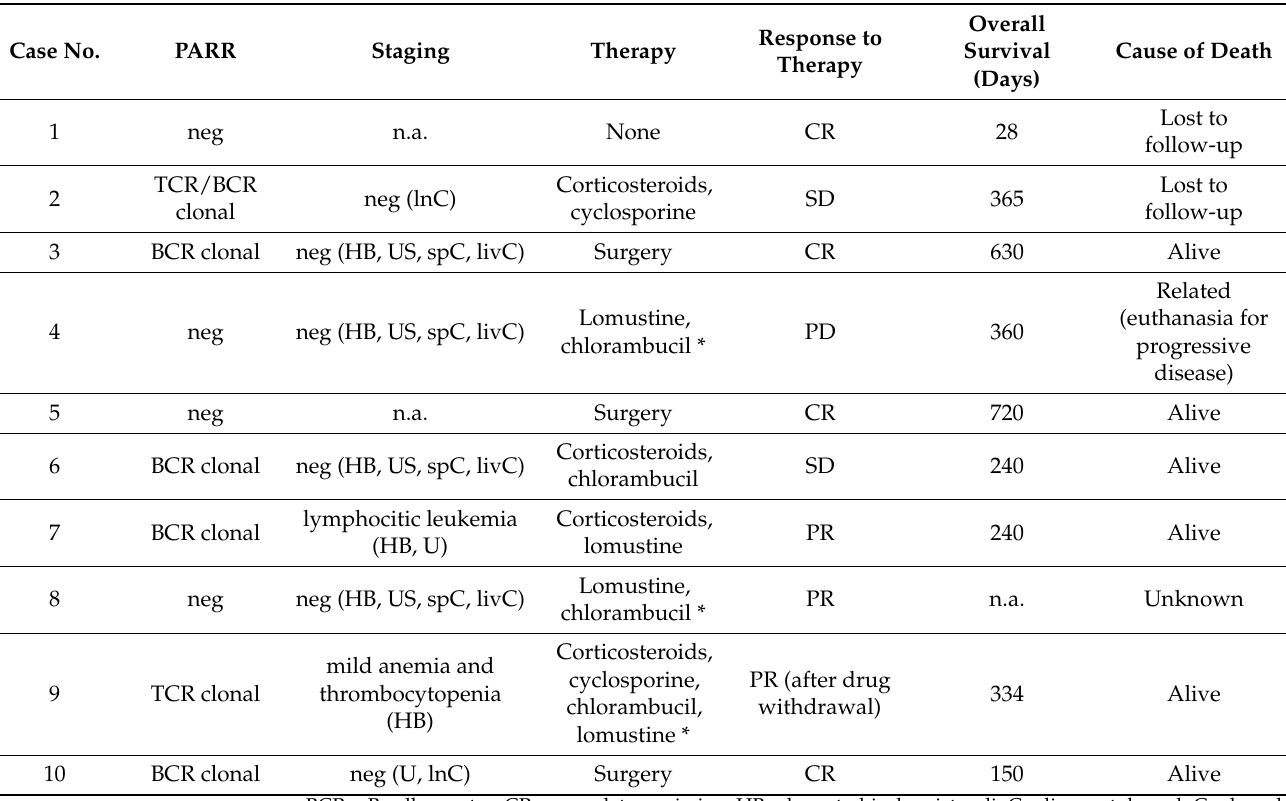
Table 4. Data on clonality testing (PARR), staging, therapy, response to therapy, overall survival, and cause of death in dogs with cutaneous